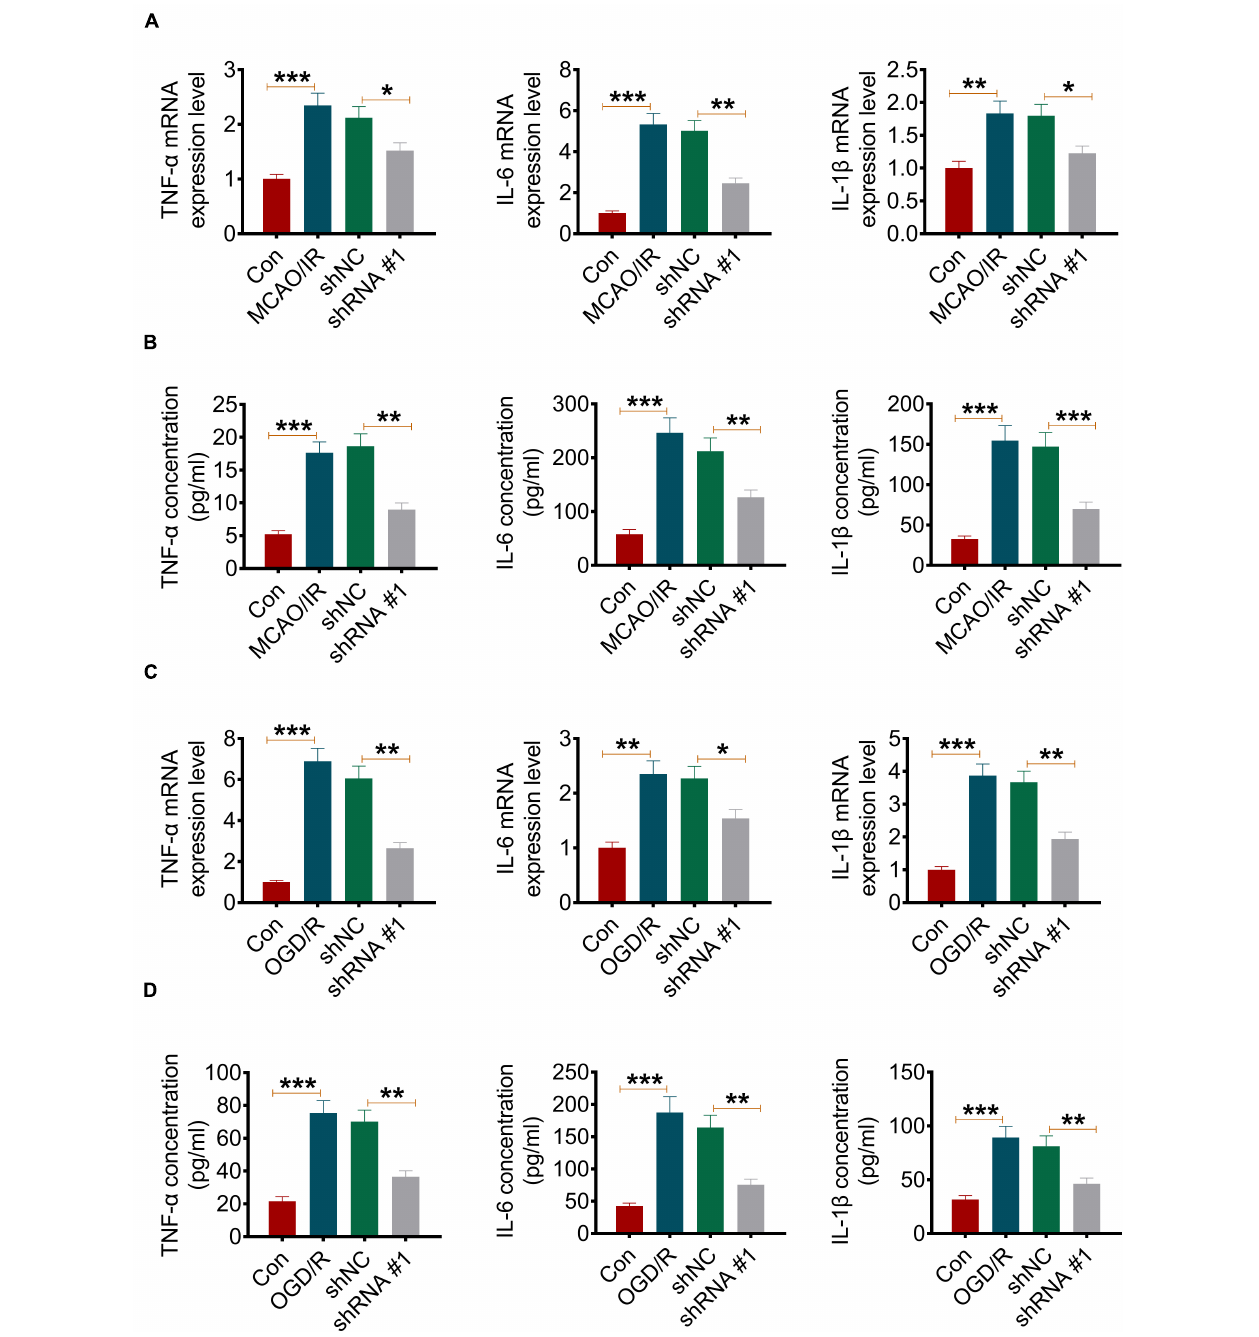
FIGURE 3 | Knockdown of ATP2B1-AS1 decreases the expression of TNF- α , IL-1 β , and IL-6 in MCAO/IR rats and OGD/R PC12 cells. (A) The mRNA expression of TNF- α , IL-1 β , and IL-6 in infarct brain tissues of the MCAO/IR rats was determined by qRT-PCR. (B) The content of TNF- α , IL-1 β , and IL-6 in infarct brain tissues of MCAO/IR rats was determined by ELISA. (C) The mRNA expression of TNF- α , IL-1 β , and IL-6 in OGD/R cells was determined by qRT-PCR. (D) The content of TNF- α , IL-1 β , and IL-6 in OGD/R cells was determined by ELISA. * P < 0.05, ** P < 0.01, *** P < 0.001.